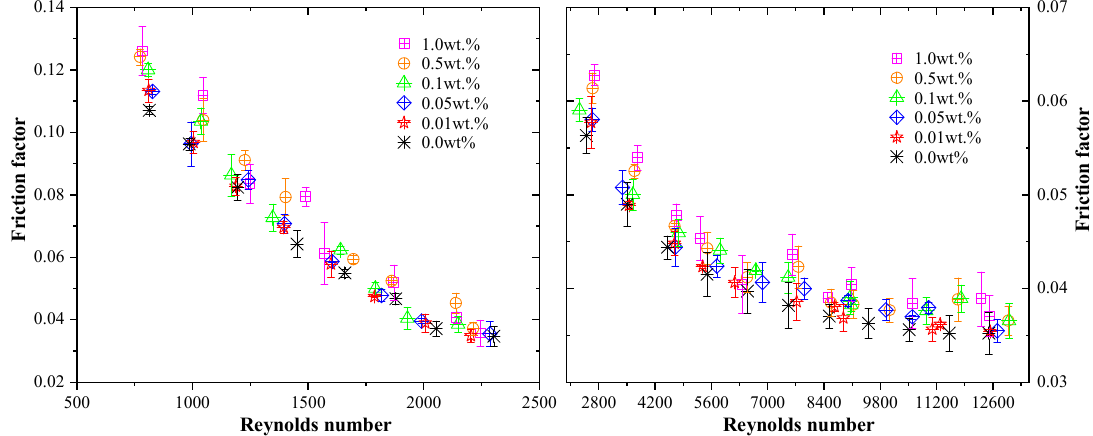
Figure 5. E ff ects of nanofluids mass fraction on friction factor in laminar and turbulent Figure 5. Effects of nanofluids mass fraction on friction factor in laminar and turbulent flow.